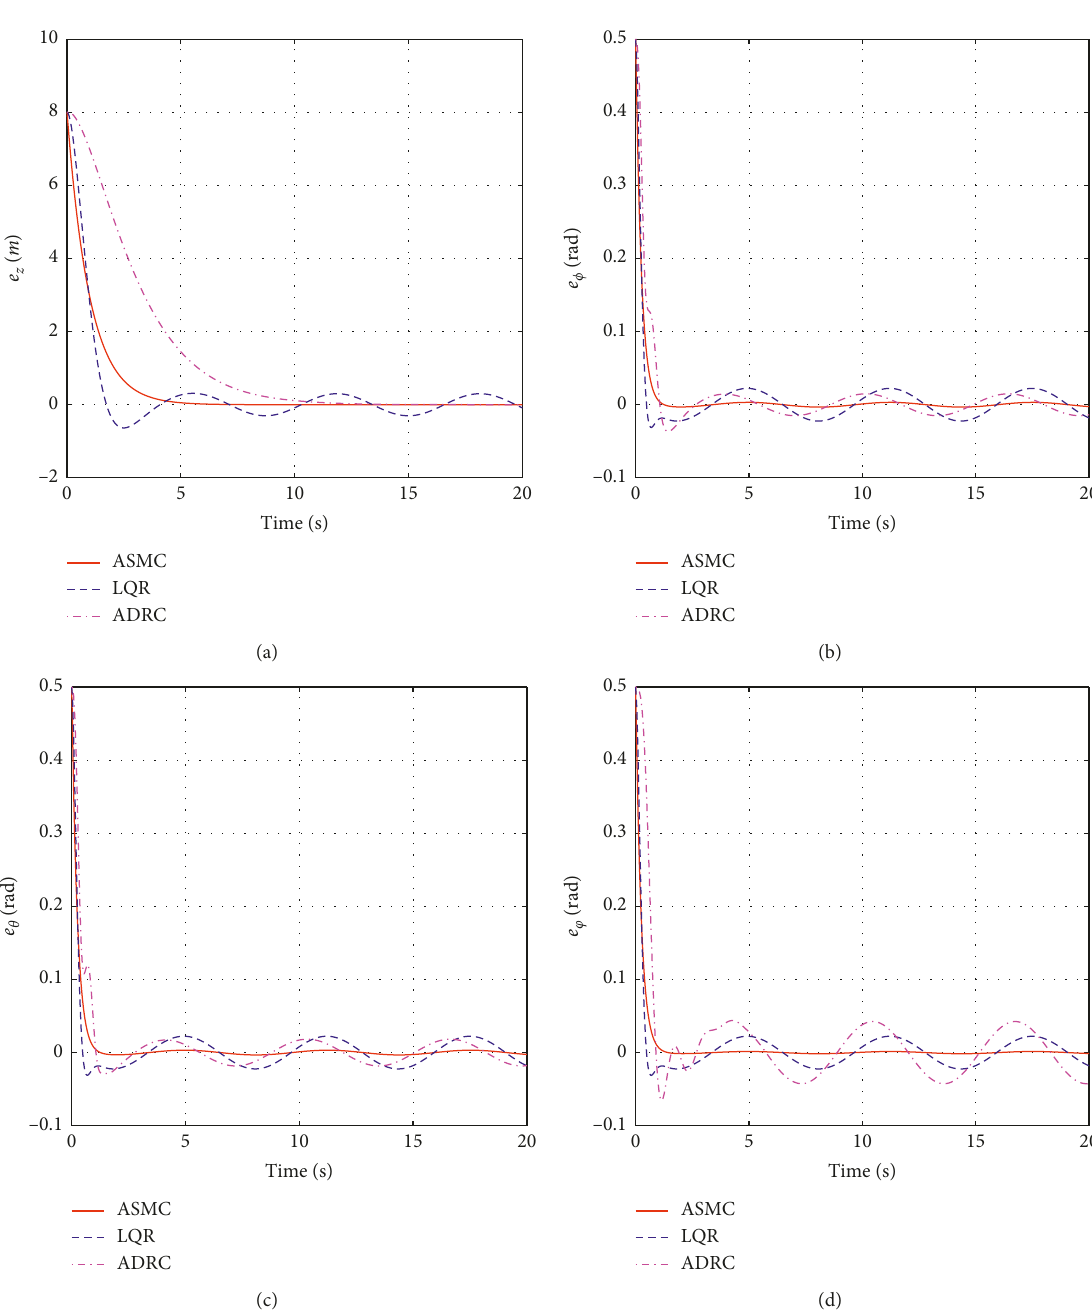
Figure 4: The output tracking error profiles in altitude and attitude